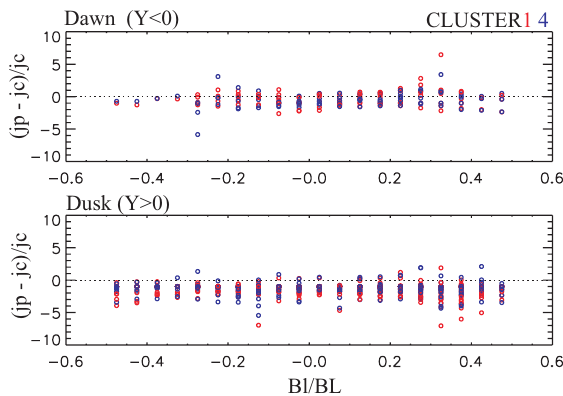
Fig. 10. Differences of proton ( j p ) and curlometer ( j c ) currents along the m direction in the morning (a) and evening (b) sectors, normalized by the absolute value of the curlometer